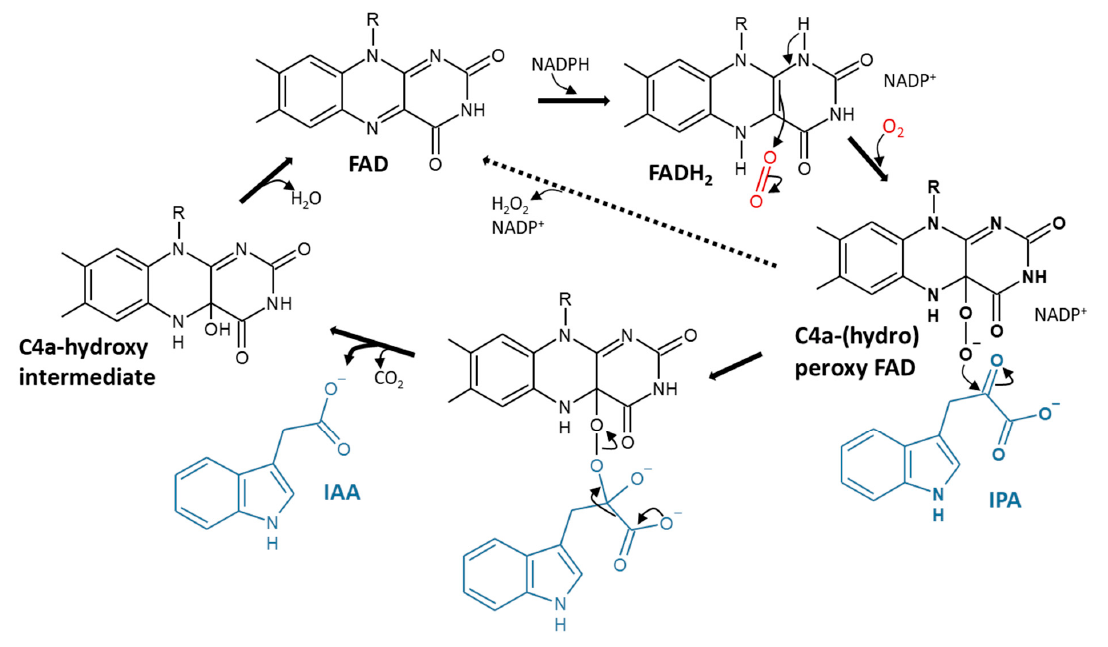
Figure 4. Proposed catalytic mechanism of the plant FMO enzyme, YUC6. YUC6 utilizes FAD and NADPH as cofactors, whereby FAD is reduced by NADPH, and thereafter reacts with dioxygen (red) to form a moderately stable C4a-(hydro)peroxy FAD intermediate. This intermediate reacts with IPA to form IAA, via an oxidative decarboxylation (drawn in blue). In the absence of the substrate IPA, the C4a-(hydro)peroxy intermediate decays into oxidized FAD and hydrogen peroxide, a process known as uncoupling (depicted by the dotted line). The R group denotes ribitol-adenosine-diphosphate. FAD: flavin adenine dinucleotide phosphate; FADH 2 : flavin adenine dinucleotide; IAA: Indole acetic acid; IPA: Indole-3-pyruvate; NADPH: nicotinamide adenine dinucleotide phosphate. Figure modified from